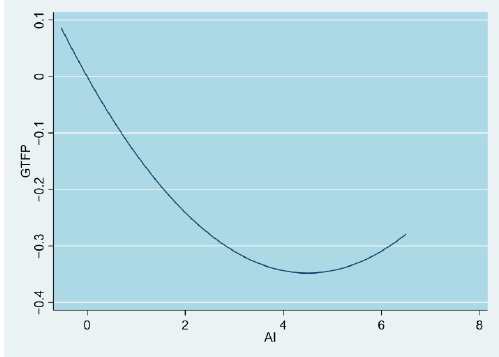
Figure 1. GTFP and AI relationship